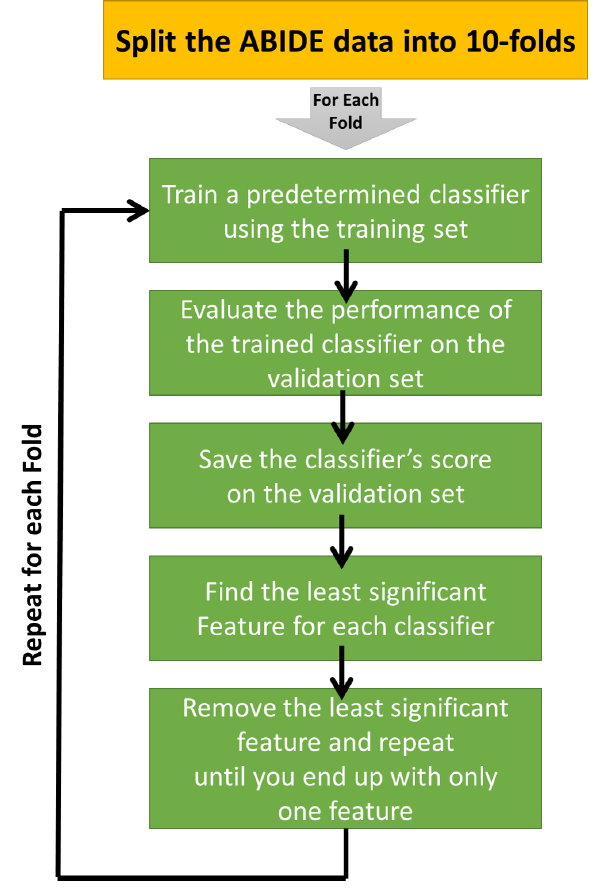
Figure 4. The flowchart of The RFECV